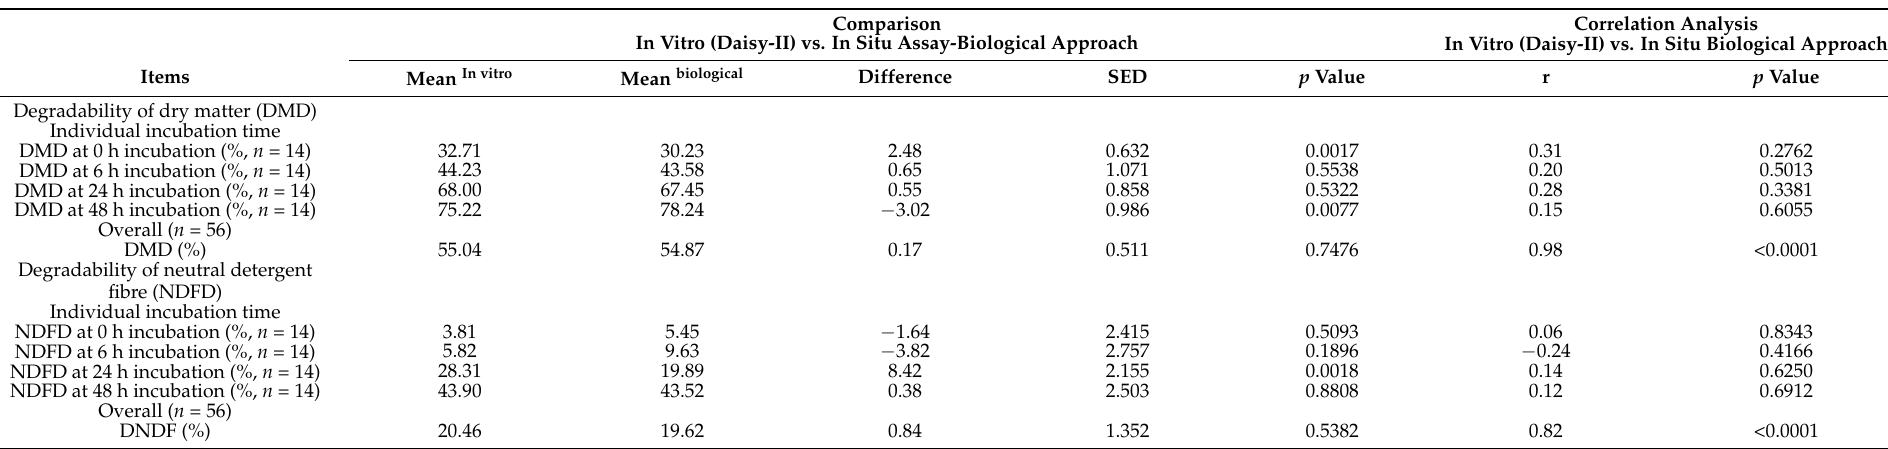
Table 4. Comparison and correlation analysis between in vitro approach (DaisyII incubation method) and in situ assay-biological approach (nylon bag technique) in the determination of degradability of dry matter (DMD) and neutral detergent fibre (NDFD) at different incubation times for whole plant faba bean silage pre-treated fibrolytic enzyme 1 derived from Trichoderma reesei at different dose levels 2